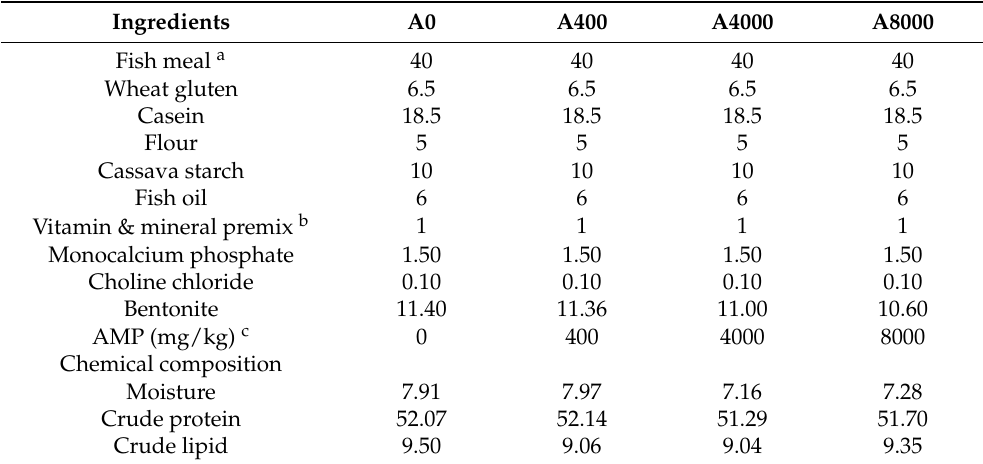
Table 1. Formulation and composition of experimental diets (dry matter,